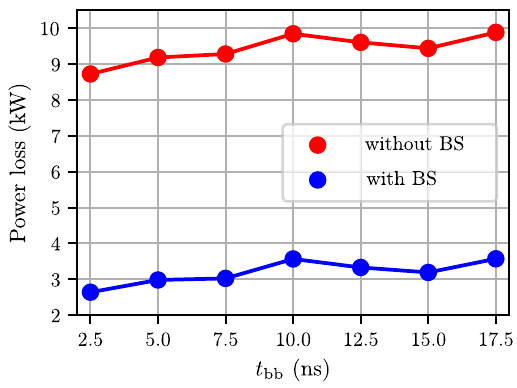
FIG. 14. Power losses for parameters of the Z machine (colliding and noncolliding beams) as a function of the bunch